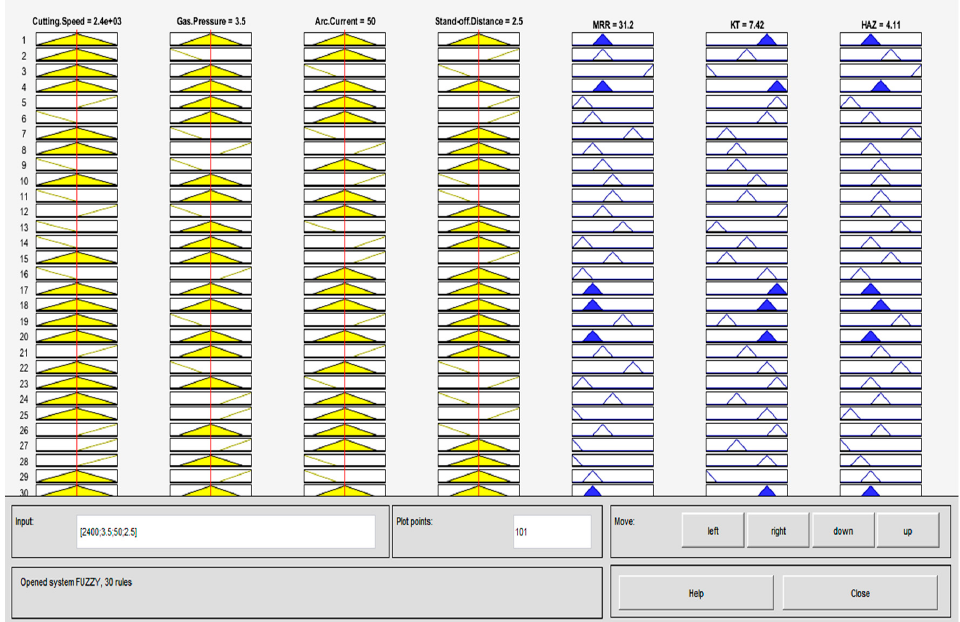
Figure 6. Fuzzy rule viewer with a triangular membership function.